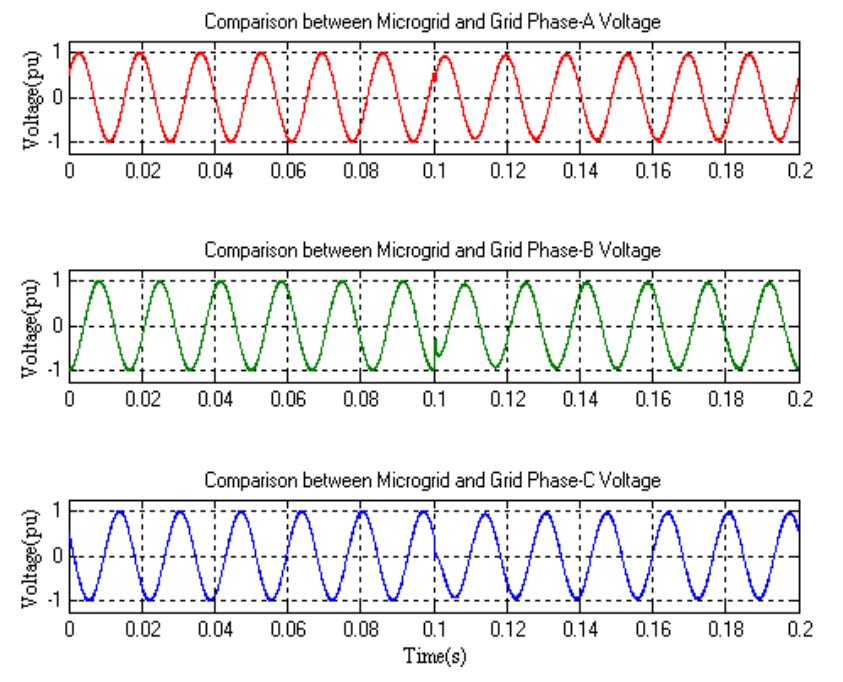
Figure 11. The circuit analysis of the transition from island mode to grid-connected